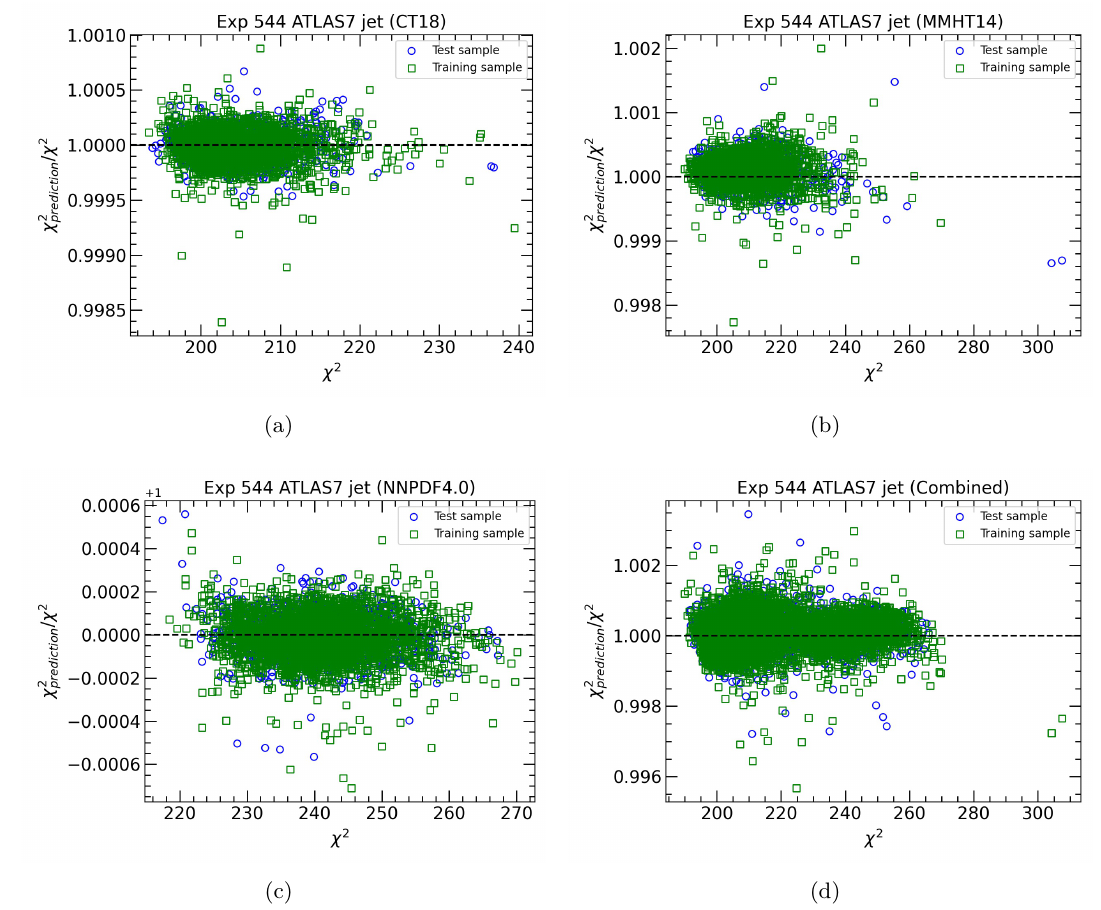
Figure 24 . The predictions to truths ratios of χ 2 for measurement of the inclusive jet cross sections √ at s = 7 TeV by ATLAS when training the NNs to individual PDF parametrization forms including CT18, MSHT14 and NNPDF4.0, or an ensemble of PDF replicas of the